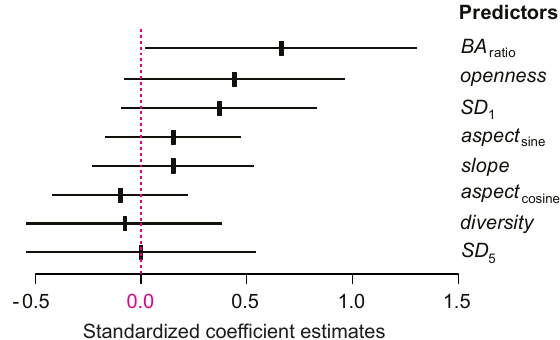
Fig. 2. The standardized coefficient estimates for all predictors re- sulting from the BMA modeling. The vertical bar at each horizontal line denotes the coefficient’s expected value, from which the ends extend to two times the standard deviation derived from the coeffi- cient’s posterior distribution. We consider a predictor to be impor- tant if these horizontal lines do not include